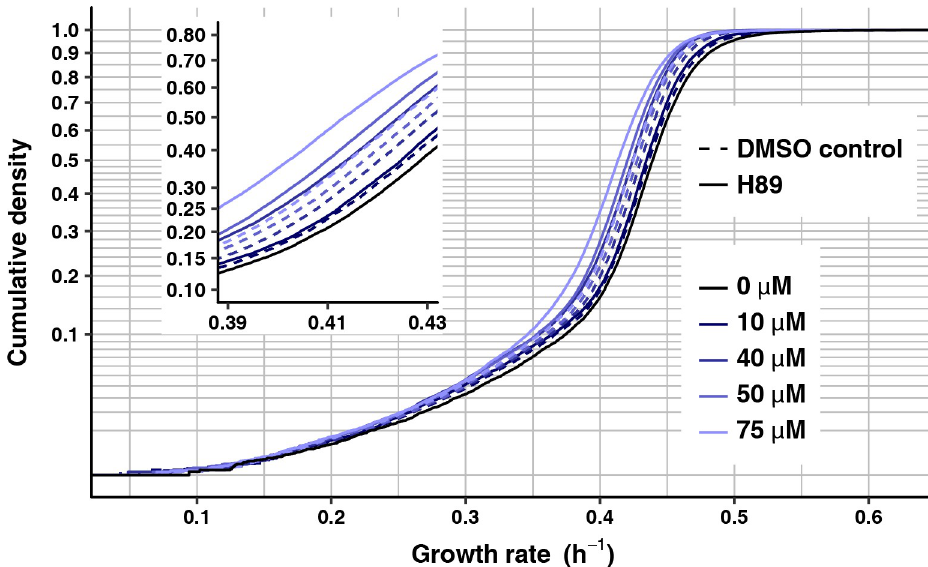
Fig 7. Treatment with PKA inhibitor H89 reduces growth rate. Growth-rate cumulative density curves of FY4 without H89 treatment (solid, black line, 16720 microcolonies) or treated with 10 μ M (17612 microcolonies), 40 μ M (19498 microcolonies), 50 μ M (19528 microcolonies) and 75 μ M H89 (20505 microcolonies) (solid lines of increasingly light shades of blue) and matched DMSO controls (10 μ M, 16559 microcolonies; 40 μ M, 19334 microcolonies; 50 μ M, 18869 microcolonies; and 75 μ M H89, 19551 microcolonies) (dashed lines). The inset plot shows the same data, zoomed into the growth-rate range between 0.39 and 0.43. Vertical axes are on a square-root scale for a better view of the slower-growing tail of each distribution. 50 μ M H89: 0.410 h –1 , DMSO control: 0.417 h –1 , Wilcoxon-Mann-Whitney test, P < 2.2 X 10 − 16 ; at 75 μ M H89: 0.405 h –1 , DMSO control: 0.415 h –1 , Wilcoxon-Mann-Whitney test, P < 2.2 X 10 − 16 ) (Fig 7). The importance of the matched DMSO controls is evident, in that DMSO, even at the lowest concentration (0.1%, corresponding to 10 μ M H89) has an effect on